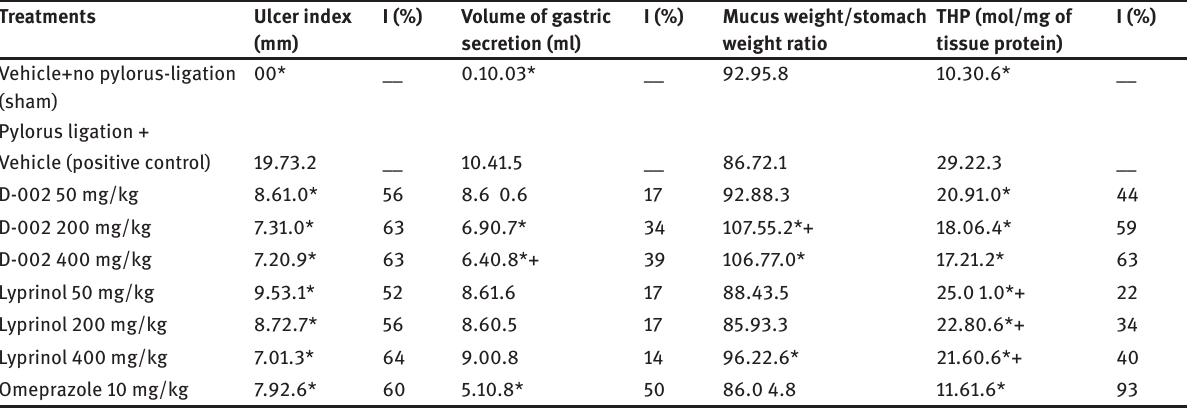
Table 3: Effects of treatments on pylorus ligation induced gastric ulcers in rats. Treatments